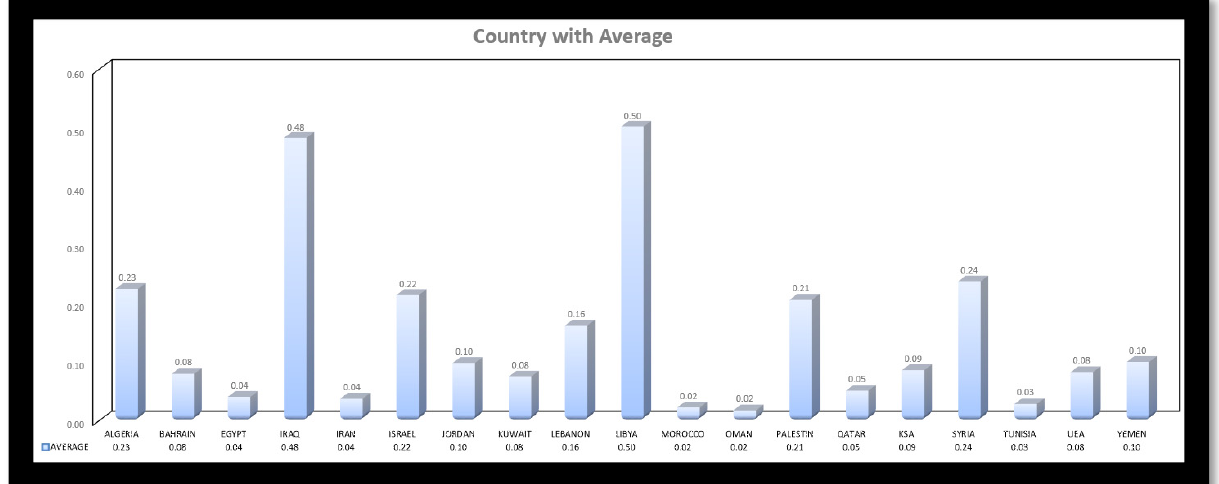
Figure 1. Average cash holding level per country.